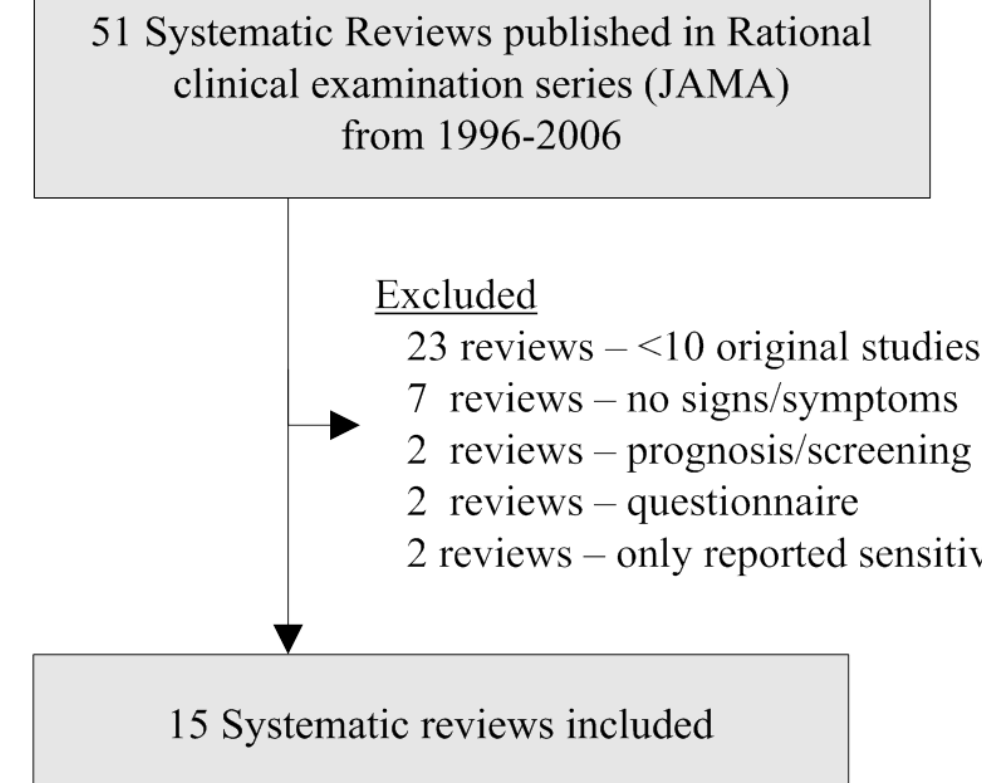
Figure 2. Flow sheet describing development of the testing